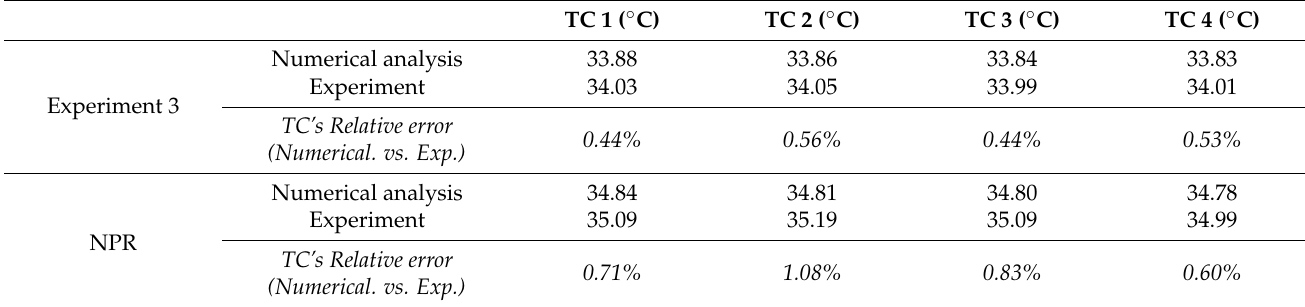
Table 7. Validations of numerical analysis for two experiments (Experiment 3 and NPR).